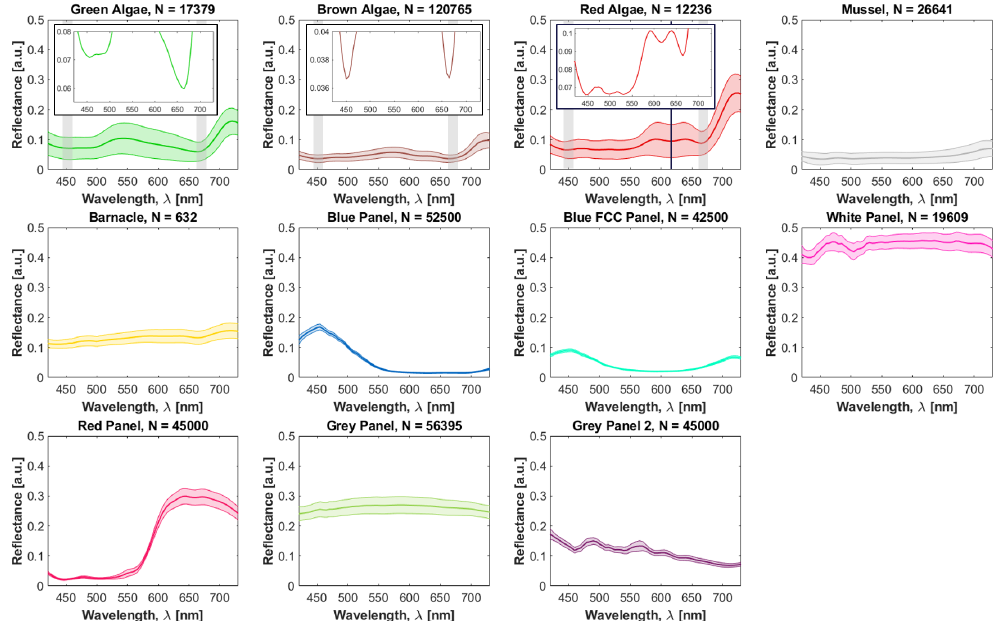
Figure 8. Mean signatures from the spectral library used as the training set for the WNN model with the coarse groups of algae. The shaded regions represent the standard deviation. For the algae signatures, the vertical gray bars indicate chlorophyll-a (chl-a) absorption bands; for the red algae, the blue vertical line indicates the in vivo satellite band absorbance peak of chl-a. For the latter classes, an inset is also shown with a zoom-in on local absorption minima. The total number of pixels sampled per class is disclosed in the title of each